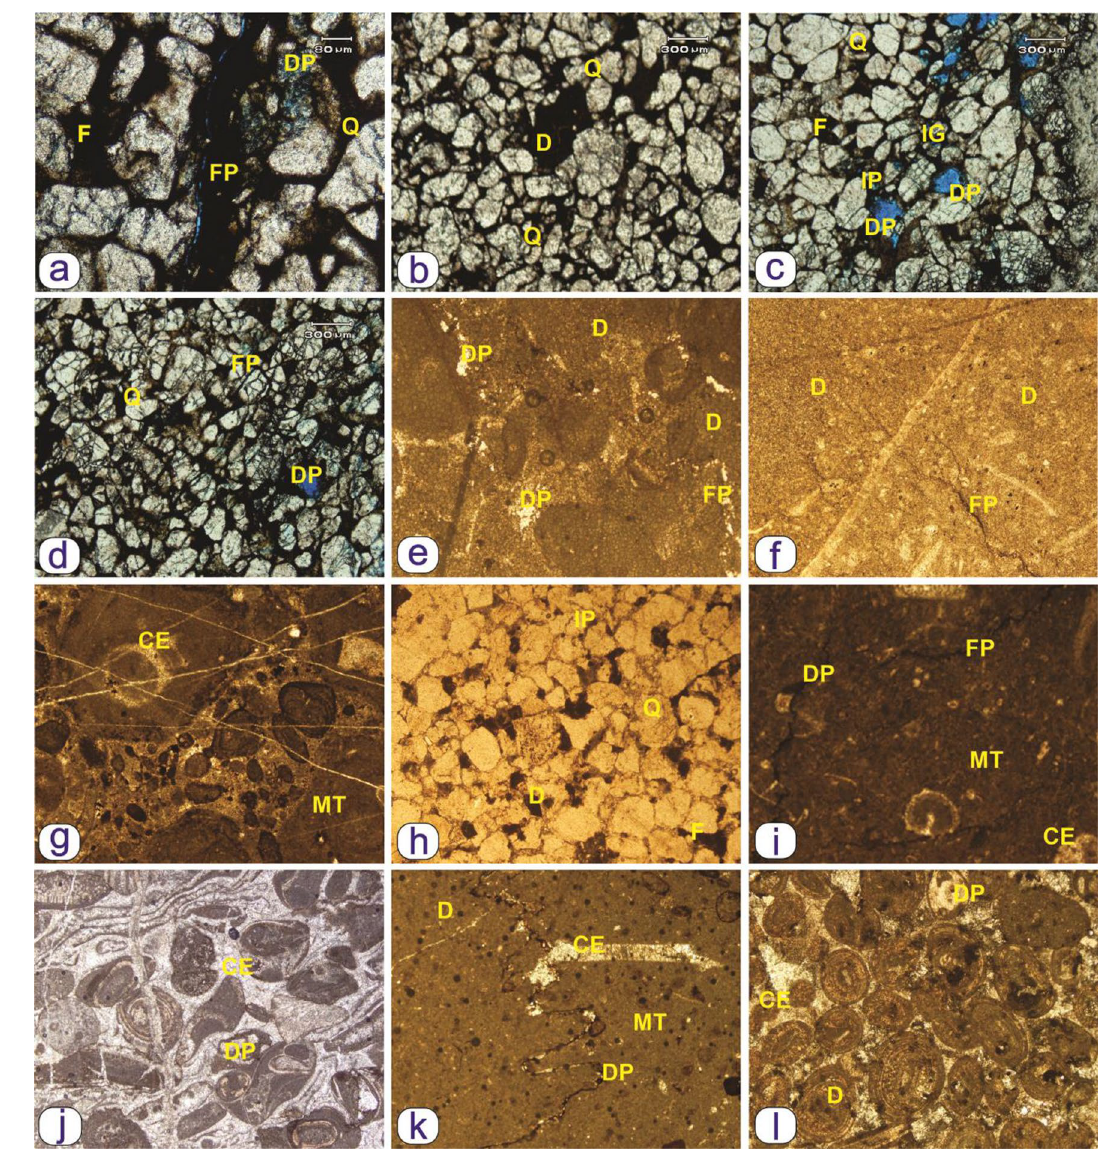
Fig. 3 Photomicrographs of the Jurassic Datta a – d , Shinawari e – h and Samana Suk i – l formations, Kala Chitta Range, Northwest Paki- stan. Ferrugenious clays (F), Fracture porosity (FP), Dissolution